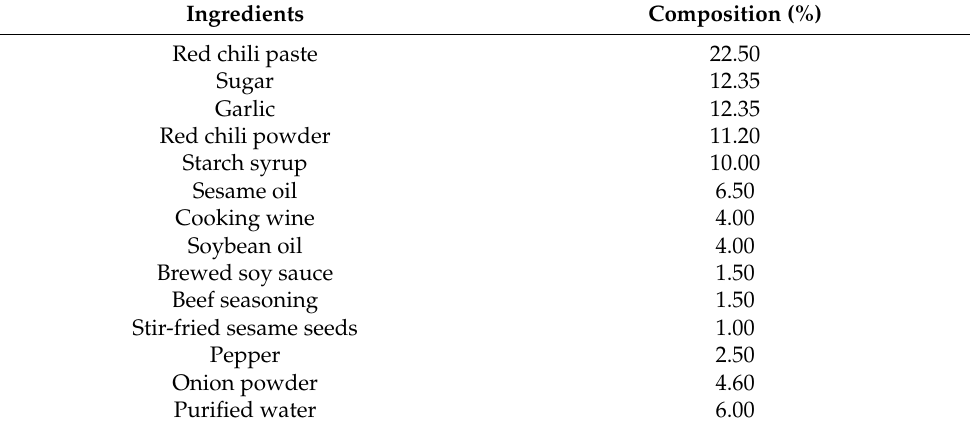
Table 1. Composition of sauce used for preparing braised mackerel with